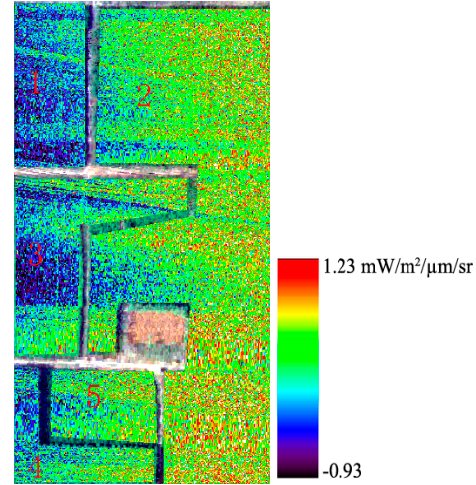
Figure 6. Retrieved fluorescence from AISA imagery using the Damm method with atmospheric information; 1: ailanthus; 2: elm; 3: mountain peach; 4: willow; and 5: Chinese ash.